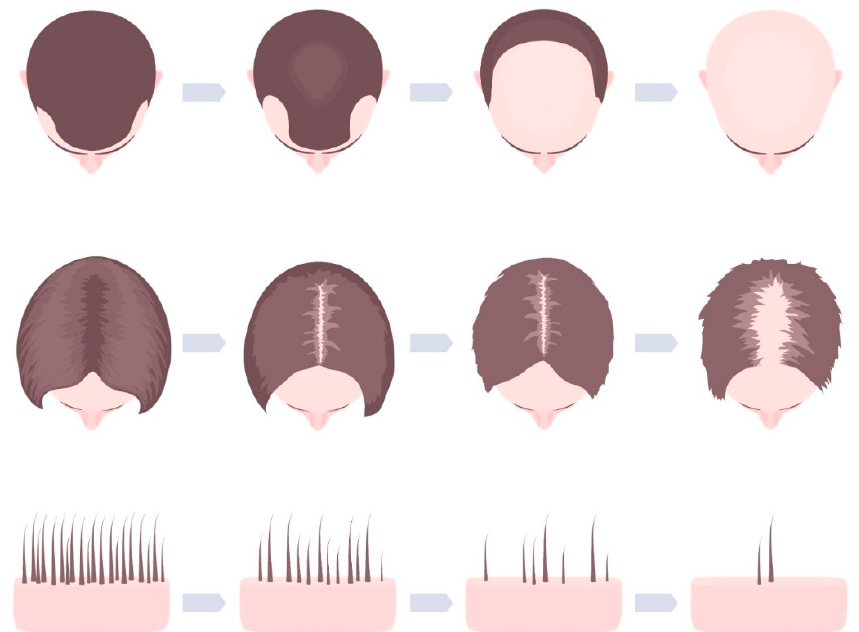
Figure 1. Typical pattern of androgenic hair loss in males (Norwood scale, above ) and females (Ludwig scale, below ).